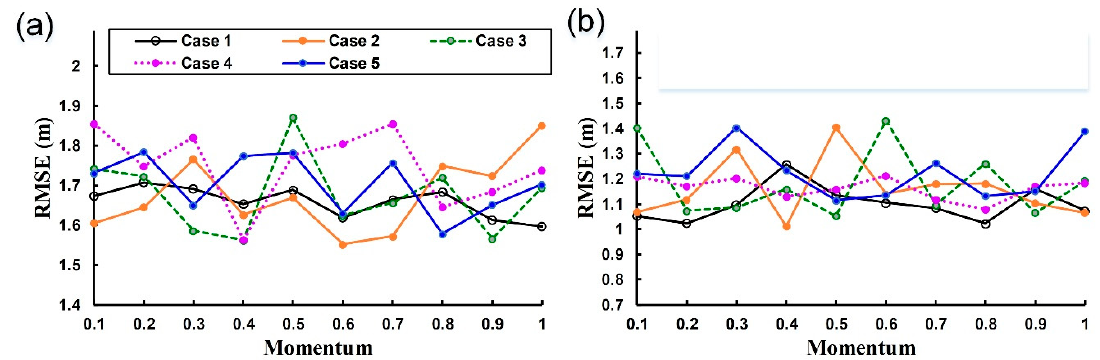
Figure 5. Parameter calibration results for momentum: ( a ) Longdong buoy and (b) Guishandao buoy.